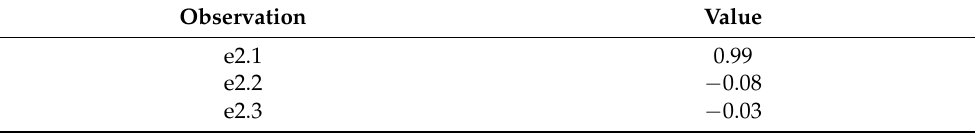
Table 2. Assignment of particular values for h2. Prepared by the authors on the basis of [2,3,53,55,56].